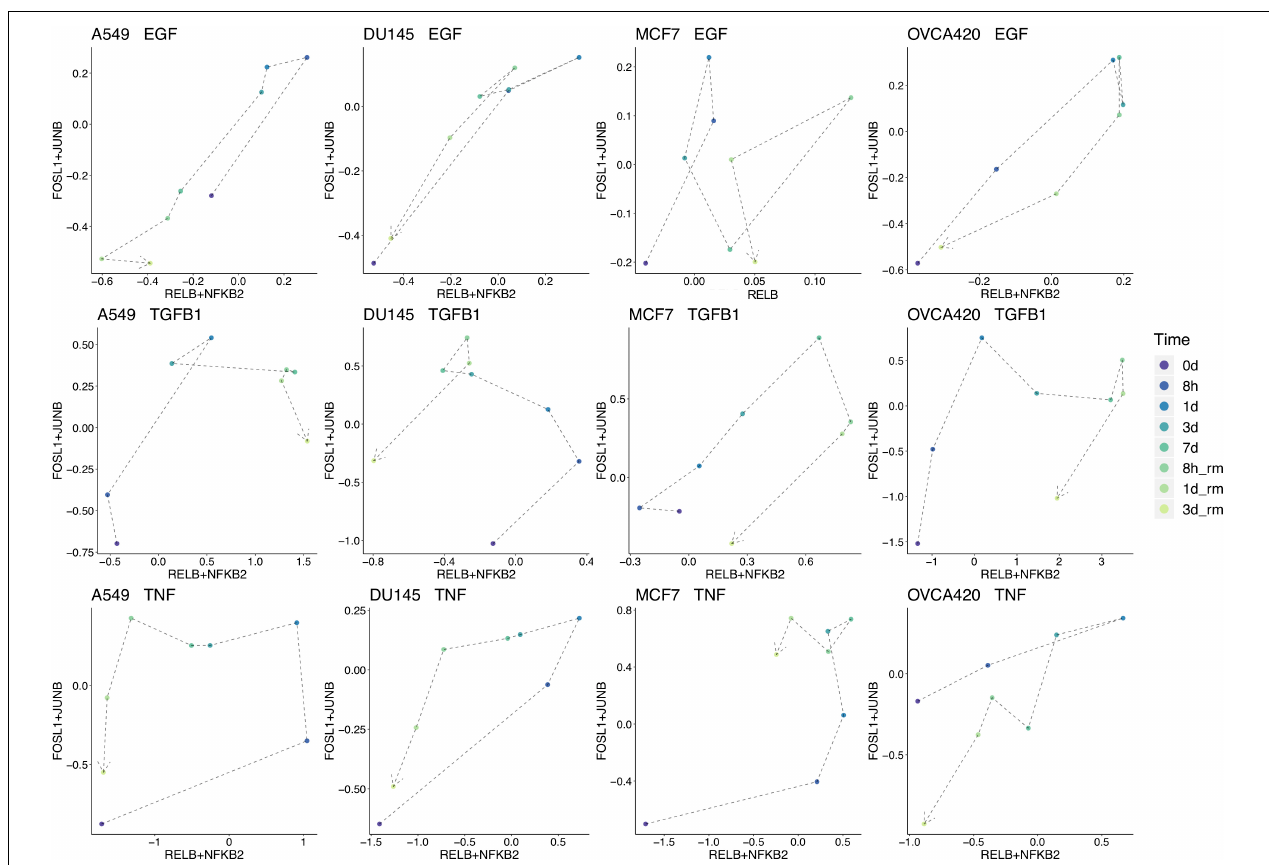
FIGURE 5 | Signal chronology across experimental conditions. Combined average TF activity of FOSL1 and JUNB vs. RELB and NFKB2 for each timepoint across each cell line and signal treatment. TF activity from 7 days onward (data from the backward direction) is scaled on a linear model to match the 7 days distributions for the forward direction. Some aspects of the EMT-MET trajectory are similar across cell lines, such as in A549, DU145, and MCF7 treated with TNF, which all follow a generally counterclockwise movement. On the other hand, the transition path is also in large part determined by cell line for all signaling conditions, such as in OVCA420, where the trajectory is generally clockwise for all inducing